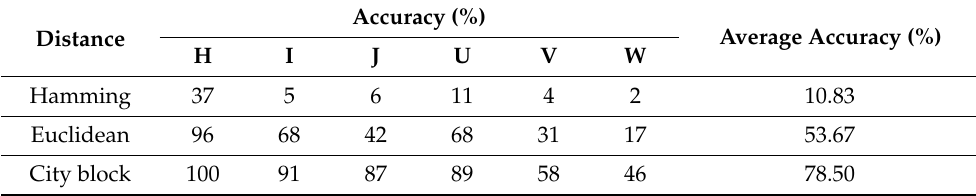
Table 5. Comparison of the results obtained using different distances with occlusion by